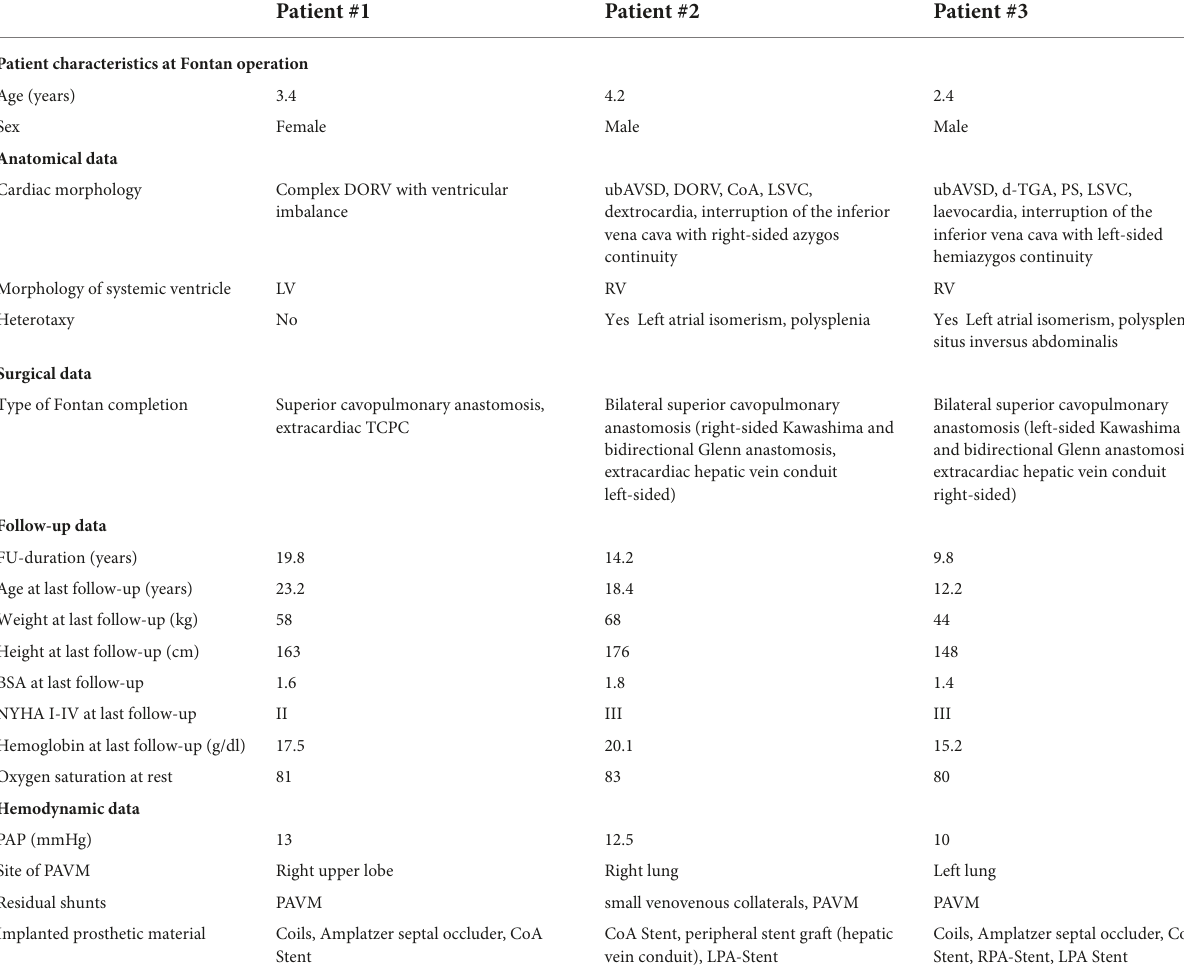
TABLE 1 Clinical summary of all